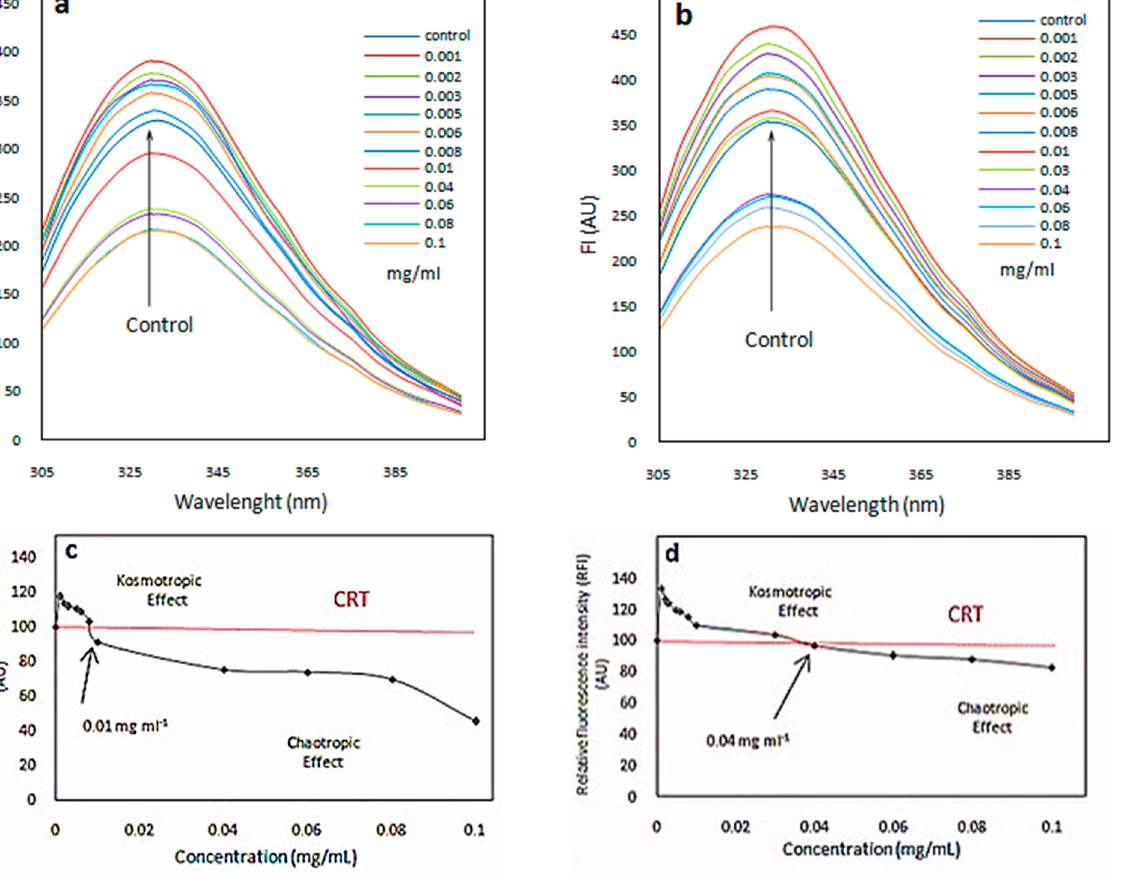
Figure 5. ( a , b ) Diagrams of tryptophan fluorescence in the presence of different concentrations of bare Fe 3 O 4 and Fe 3 O 4 @Tre NPs, respectively; ( c , d ) diagrams of the relative fluorescence intensity showing a dual concentration effect of Fe 3 O 4 and Fe 3 O 4 @Tre NPs compared to the control state (absence of NPs), respectively.